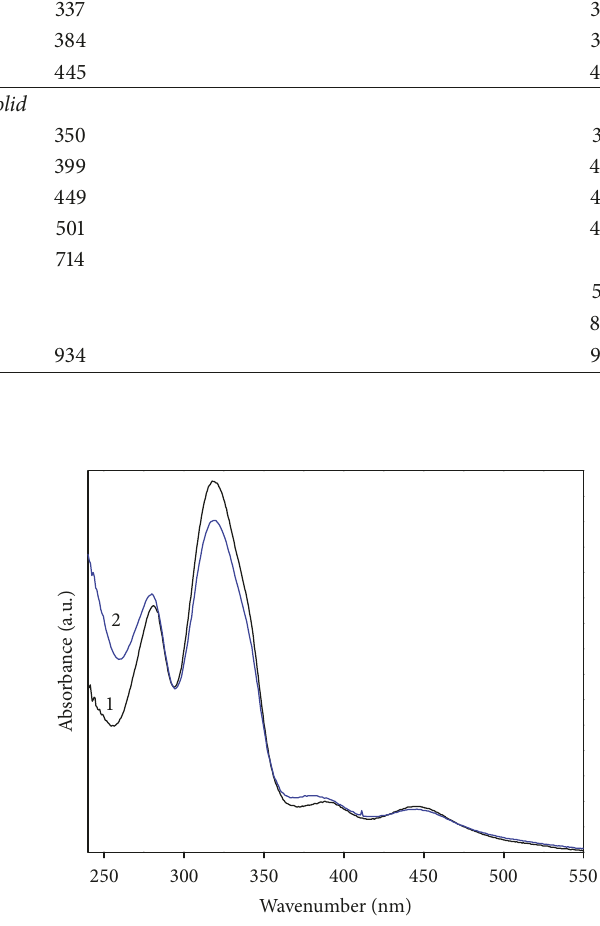
Figure 1: Absorption spectra of chloroform solution of 1 and 2 , in